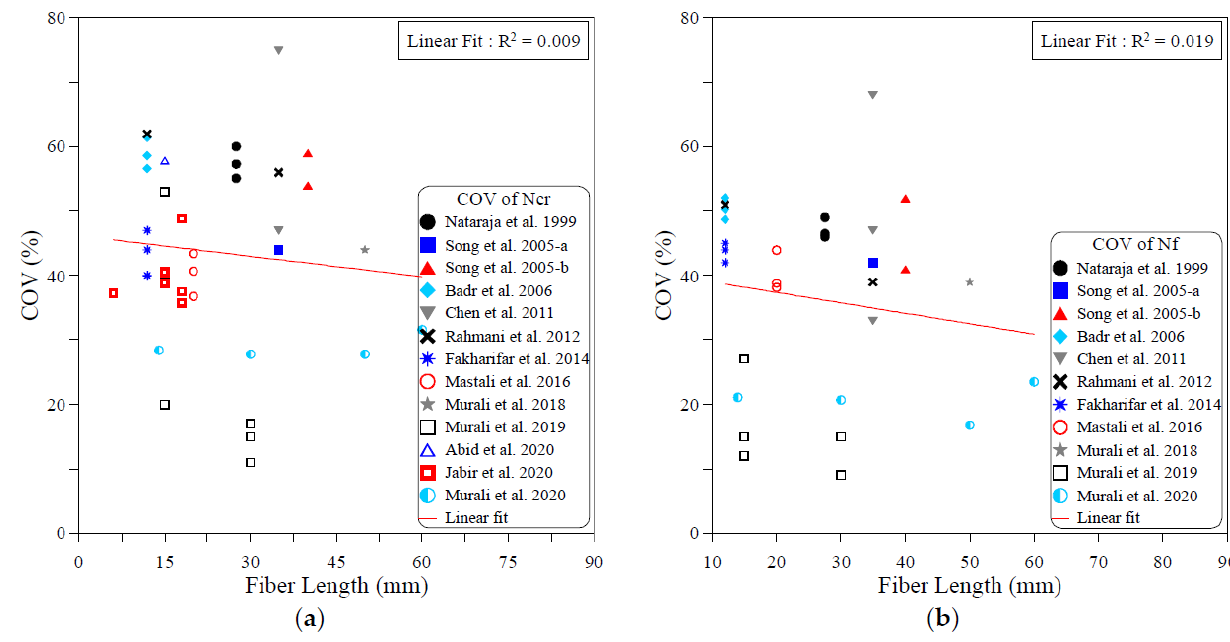
Figure 6. Effect of fiber content on the scattering of impact results at ( a ) cracking and ( b ) failure.